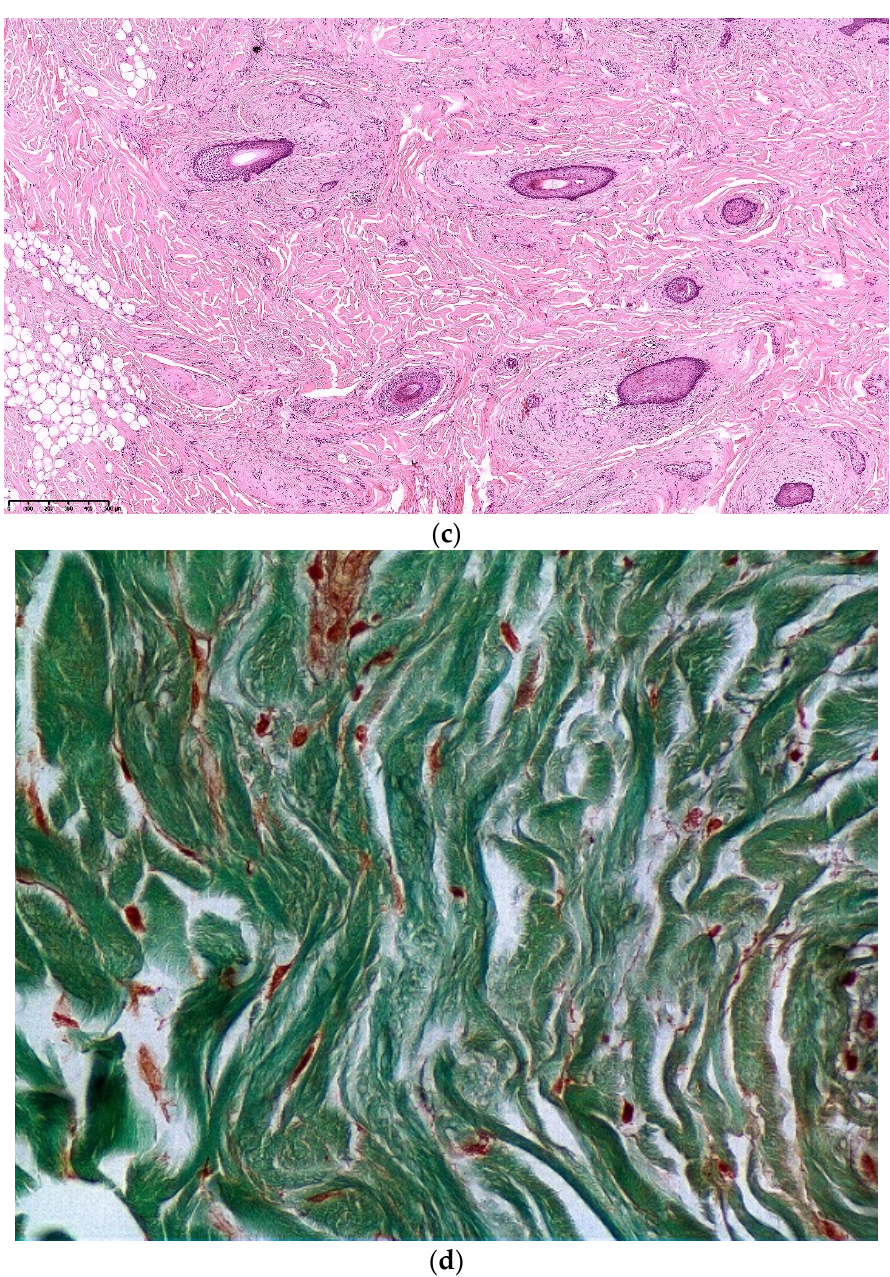
Figure 5. Shagreen patch. ( a ). Clinical aspect of a lumbar shagreen patch; ( b ). Hematein eosin ×20: extensive fibrosis with collagen bundles into the dermis and the hypodermis; ( c ). Hematein eosin ×20: concentric perifollicular fibrosis; ( d ). Orcein staining ×40: lack of elastic fibers. SP correspond histologically to collagenomas (or collagenic hamartomas). The dermis is replaced by a dense, relatively acellular and hyaline collagen which extends down to the subcutaneous fat (Figure 5b). As in AF and FCP, follicles are also involved with a concentric perifollicular collagen, atrophy and compression (Figure 5c). Some follicles are abnormal in shape. Sometimes, they are entirely replaced by a fibrous collagenic column. Elastic fibers are thin, fragmented or absent (Figure 5d)